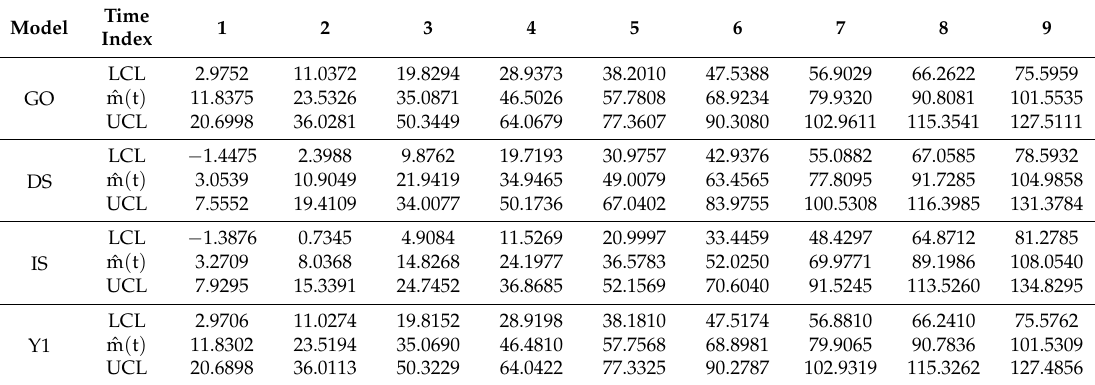
Table A1. 99% Confidence interval of all 13 NHPP SRMs from Dataset